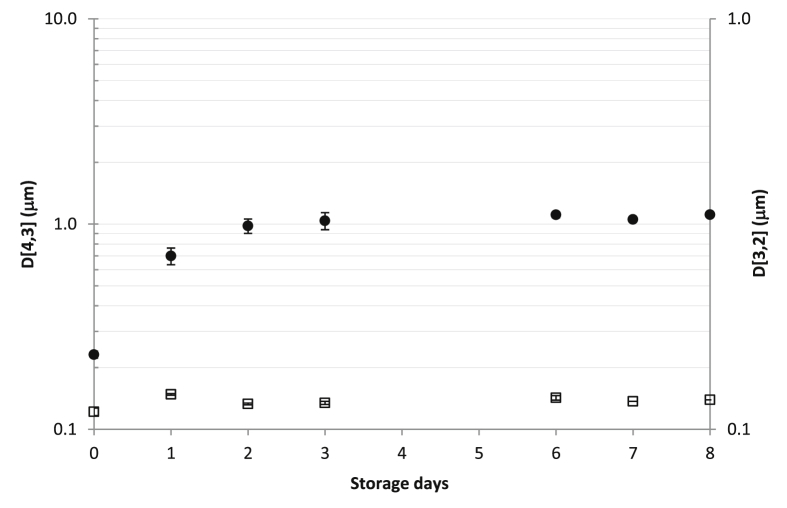
EDS (expressed as D[4,3] (Image 7) and as D[3,2] (Image 8)) of the optimal emulsion stored at 4 °C.